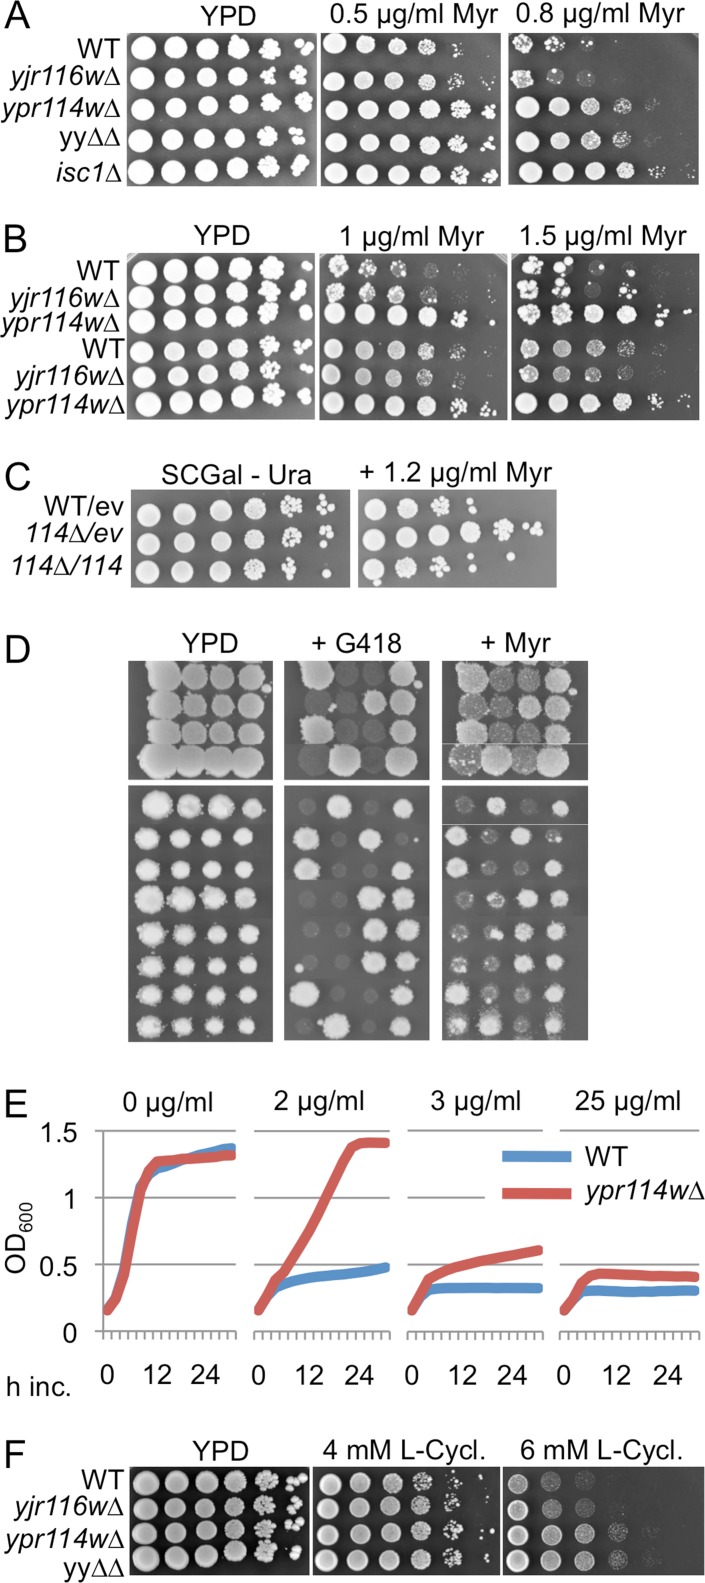
Disruption of YPR114w makes cells hyper-resistant to SPT inhibitors.A. WT and mutant strains were plated on YPD with or without myriocin (Myr) and incubated at 30°C for 3 days. B. As A, but the upper three rows show mutants in the W303 background, the lower three rows in the YPK9 background. C. As A, but ypr114w∆ cells harboring empty vector pYES2NT (ev) or the same with YPR114w (114) were plated. D. WT B4742 was crossed with ypr114w∆, tetrads were dissected and its four spores aligned horizontally. After two days, the clones were replicated onto YPD media supplemented with nothing, G418 or myriocin (1.2 μg ml-1). E. Growth of WT = BY4742 and ypr114w∆ in liquid YPD with concentrations of myriocin indicated at the top. F. As A, but with SPT inhibitor L-cycloserine.